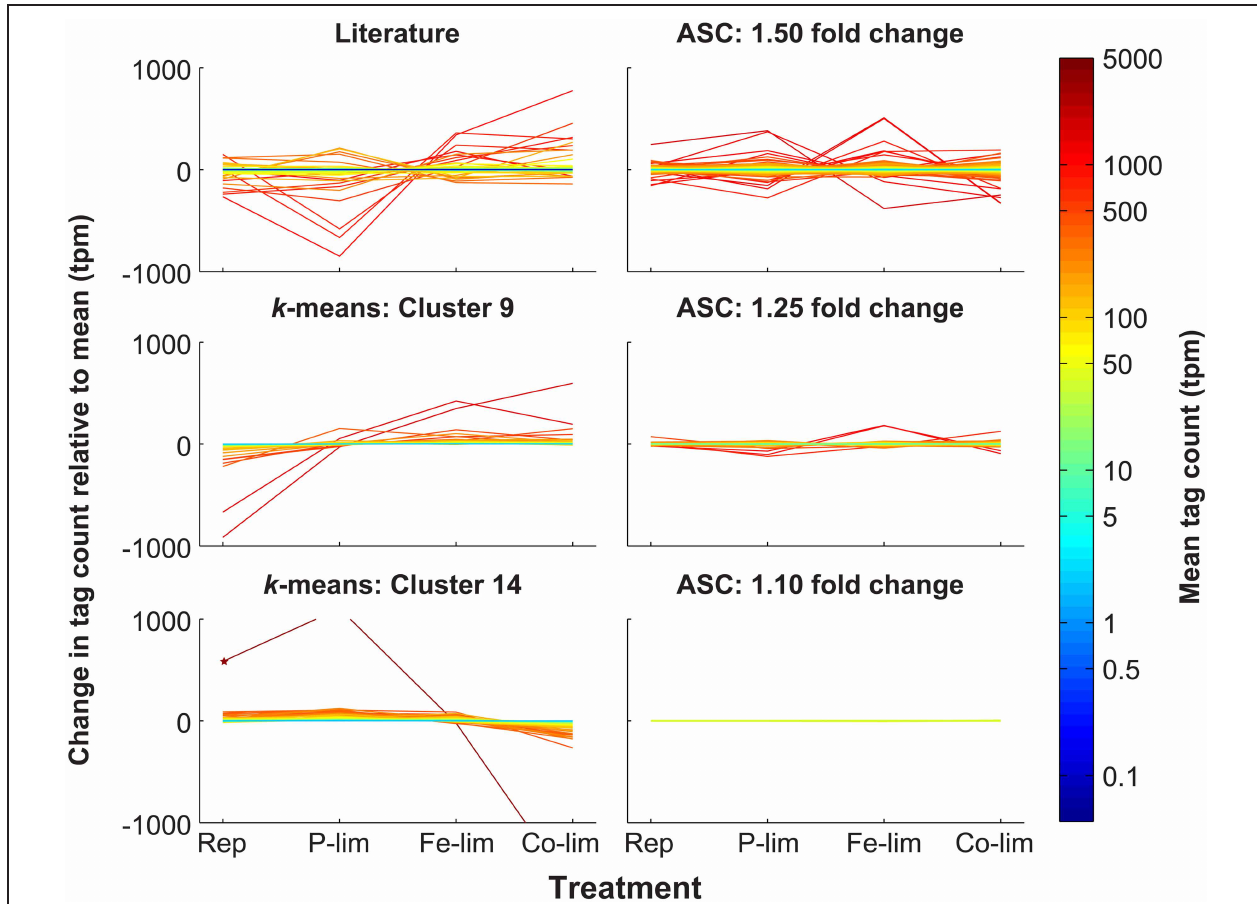
control. Genes from these fold change bins are plotted to indicate deviation and mean tpm (ASC: 1.50 fold change; ASC: 1.25 fold change; ASC 1.10 fold change). For a fold change of 1.10, two genes, both hypothetical proteins, (NCBI: 7446346 and 7452192) passed the post- p < 0 . 1 cutoff, and represent the most stable genes based on the ASC analysis ( Data Sheet 3 ). For each of the six classes of putative reference genes, tag counts were normalized to total library size (in tpm) and are plotted relative to the mean for each of the four treatments: Rep, Replete; P-lim, P-limited; Fe-lim, Fe-limited; and Co-lim, Co-limited. The color of the line correlates to the mean normalized tag count. A star marks a gene (NCBI: 7451632) in Cluster 14 that is not on the scale